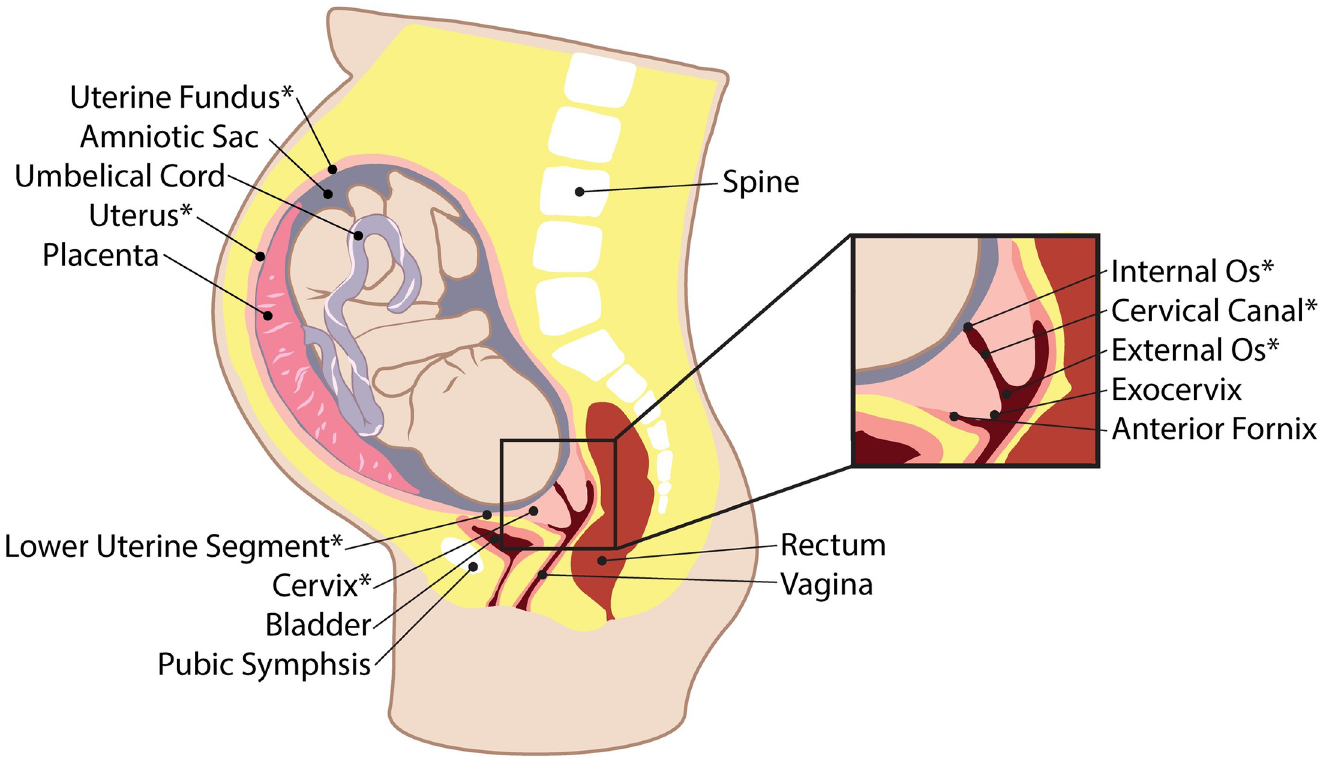
Fig 1. Pregnant anatomy. Representative illustration of a sagittal view of pregnant anatomy with relevant reproductive and surrounding structures labeled. Asterisks ( � ) indicate structures evaluated in the protocol.